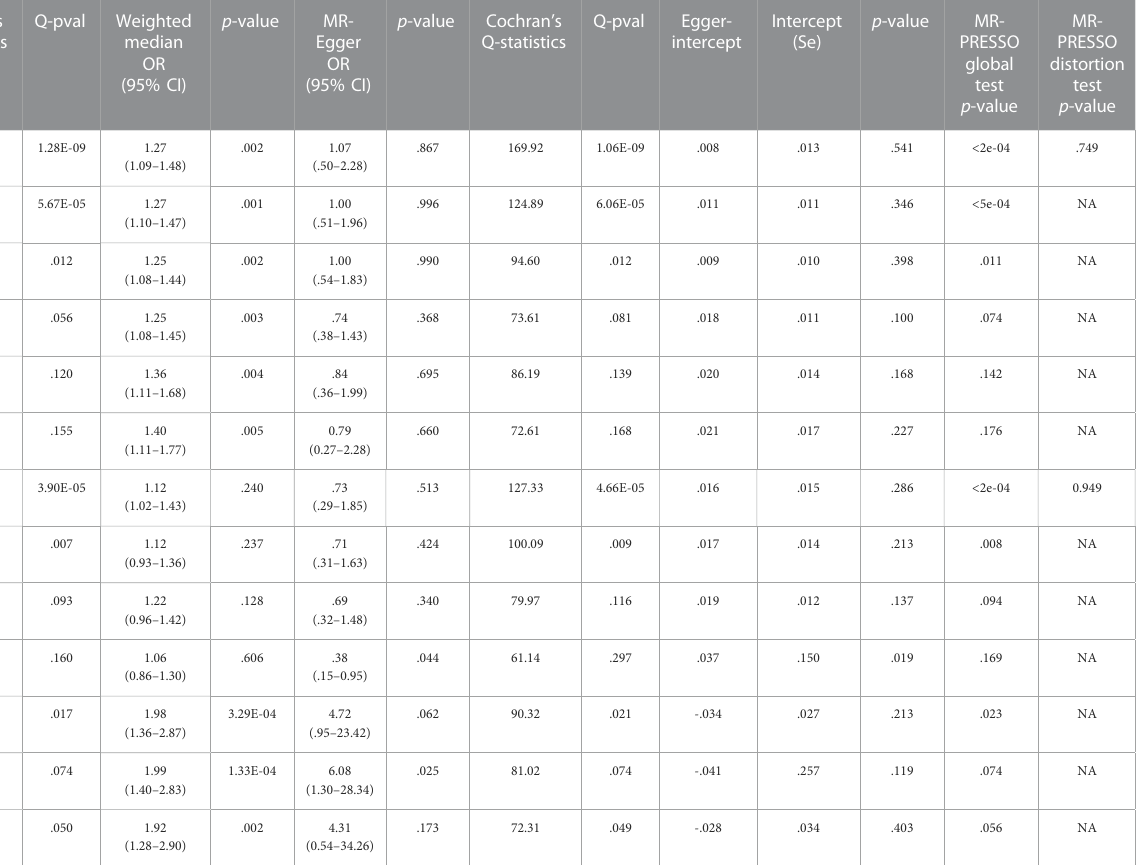
TABLE 1 MR estimates from different methods of assessing the causal effect of GERD on lung cancer and subtypes. Outcome